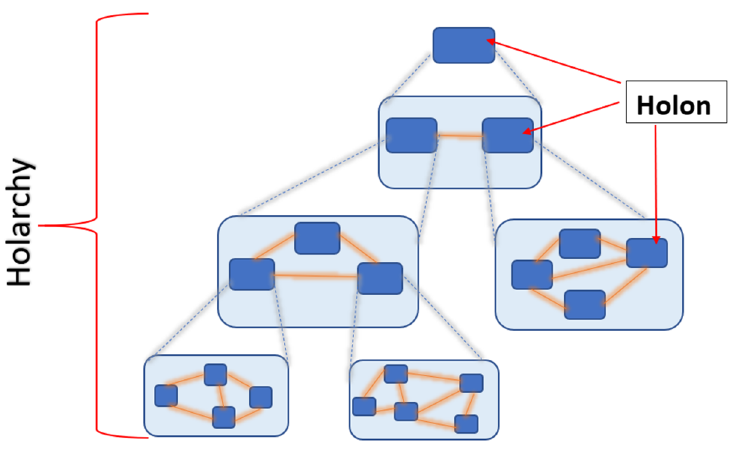
Figure 2. Holonic architecture of holons. Product–resource–order–staff architecture (PROSA) is an agent-based holonic